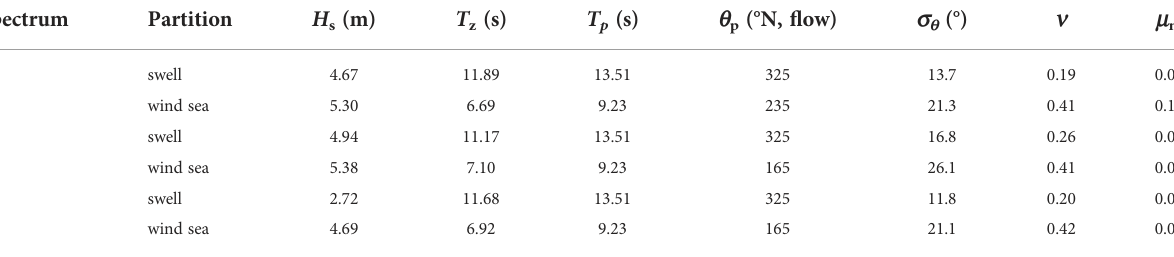
TABLE 2 Main spectral characteristics of the partitioned wave systems identi fi ed within the selected bimodal spectra. Spectrum